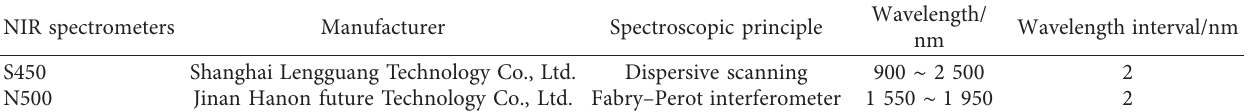
Table 2: Spectral wavelength range and sampling interval of NIR spectrometers.